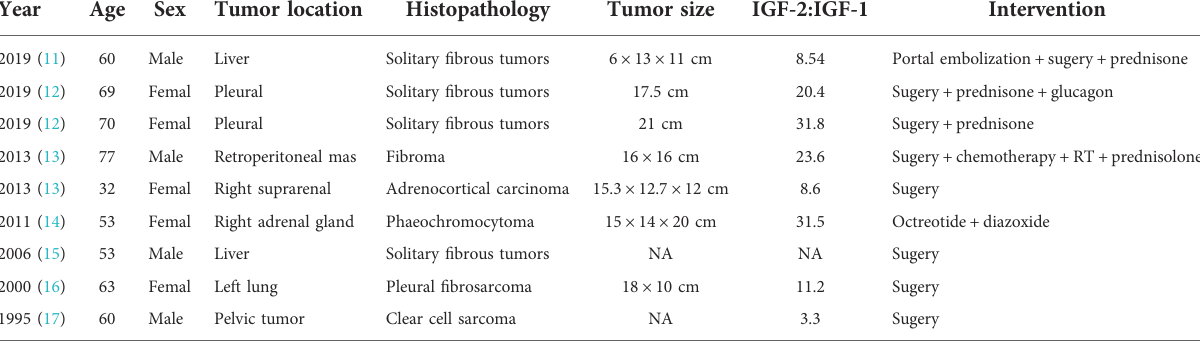
TABLE 2 Reviewed current case reports on NICTH with acromegaloid